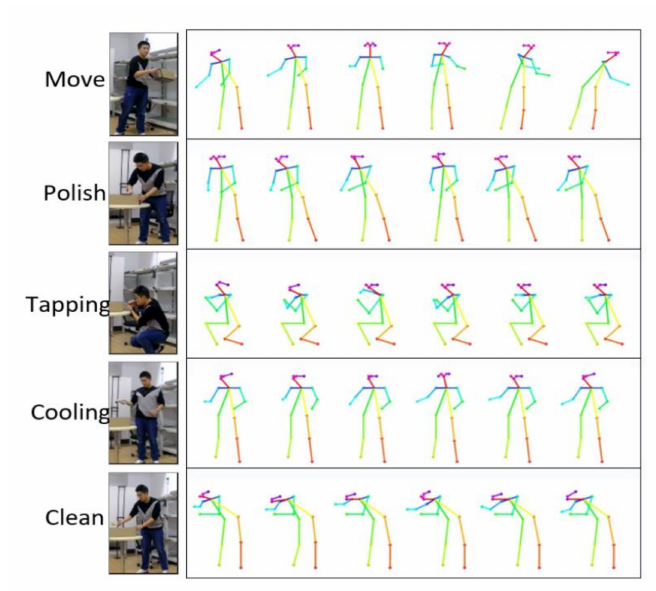
Figure 5. Sample of our dataset, including the original RGB frame and the skeleton sequence of every